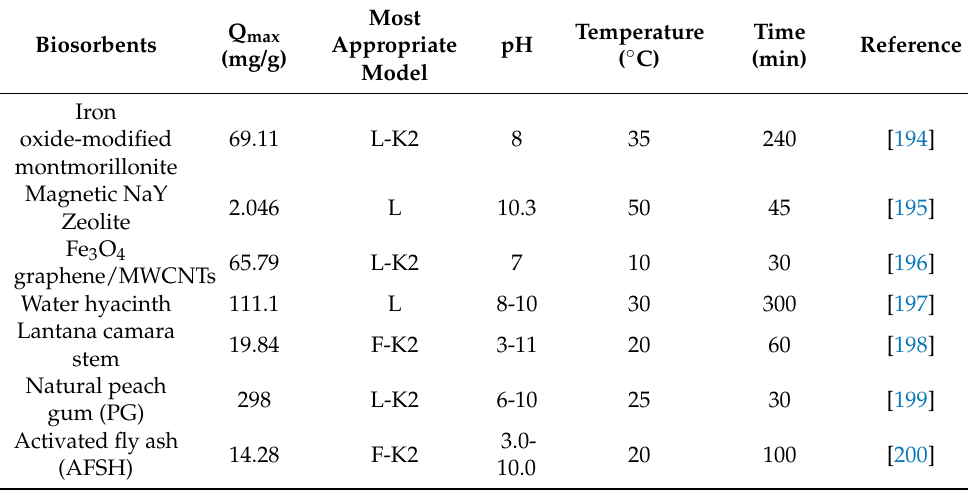
Table 6. Summary of bio-waste-derived adsorbent studies in